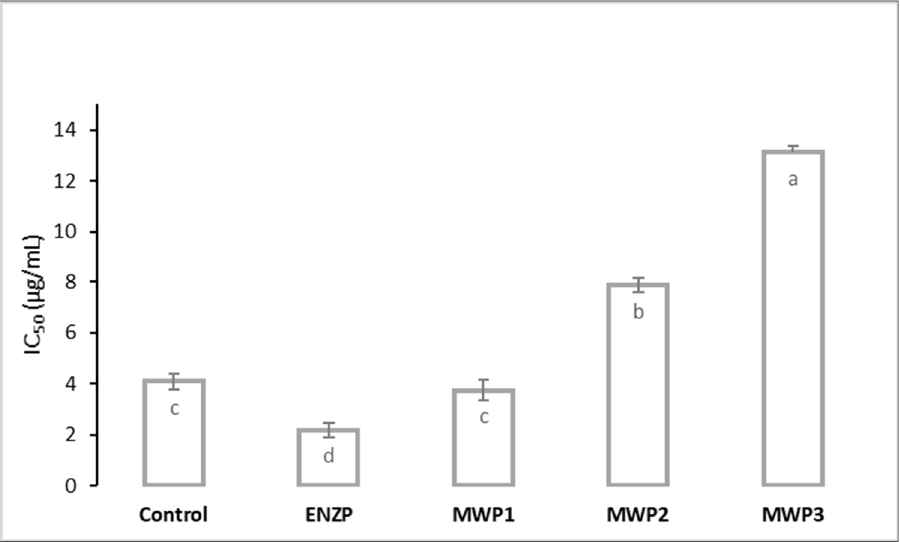
Figure 4. Antioxidant activity (expressed as IC 50 value) of oregano extracts obtained by supercritical carbon dioxide extraction (pressure 200 bar, temperature 40 °C, extraction time 4 h). Different letters (a, b, c, d) indicate significant difference between samples ( p <